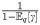
Behavioural results in the first (left of Fig 11) and second experiments (right of Fig 11).A. and B. Heat plot of the probability of visiting each state and selecting each action for the 64 agents simulated. (i) Agents progressively learned the first optimal actions (left action in state 3-4-5) during the first half of the experiment, then adapted their behaviour to the new contingency (right action in states 1-4-2). (ii) Similarly, in the second experiment, agents adapted their behaviour according to the new contingency (left action in 1-3-5). C. Efficient memory on the first and second level, and foreseeing capacity. Since the CC was less important in (ii) than in (i), because the left action in state 3 kept being rewarded, the expected value of w dropped less. The behaviour of the foreseeing capacity (11-Eq[γ]) and, therefore, of the expected value of γ, is indicative of the effect that a CC had on this parameter: when the environment became less stable, Eq[γ] tended to increase which had the effect of increasing the impact of future states on the current value. D. (i) Reward rate dropped after the CC, whereas the RT increased. The fact that subjects made slower choices after the CC can be viewed as a mark of the increased task complexity caused by the re-learning phase. Along the same line, RT decreased again when the subjects were confident about the structure of the environment. (ii) The CC had also a lower impact on the reward rate and RT in experiment (ii).